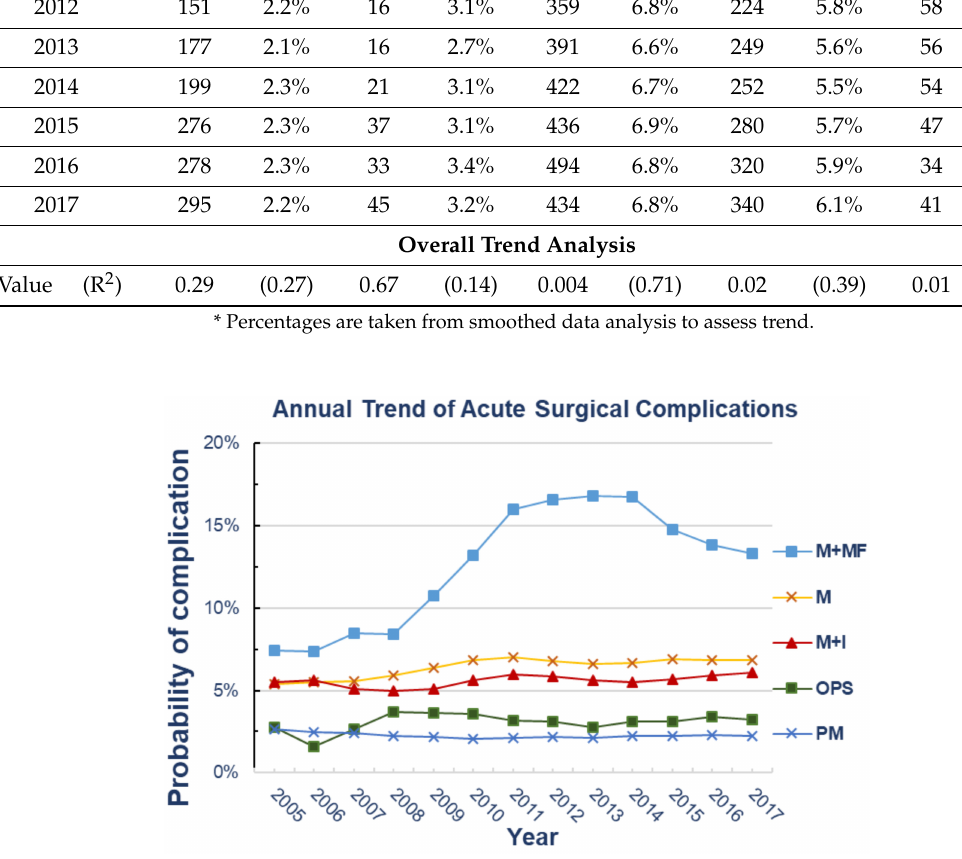
Figure 1. Annual trend analysis showing complication rate within each surgical category. PM: Partial Mastectomy; OPS: Oncoplastic Surgery; M: Mastectomy; M + MF: Mastectomy with Muscular Flap reconstruction; M + I: Mastectomy with Implant